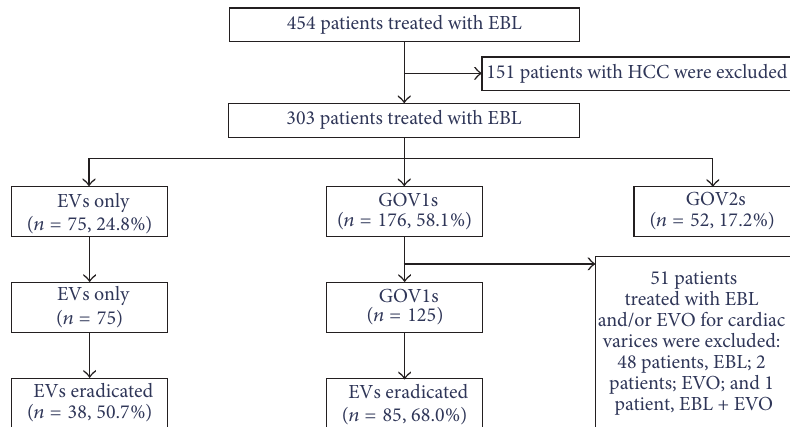
Figure1:Flowchartofpatientswhohadbeentreatedusingendoscopicbandligation.EBL:endoscopicbandligation;EVs:esophagealvarices; GOVs: gastroesophageal varices; HCC: hepatocellular